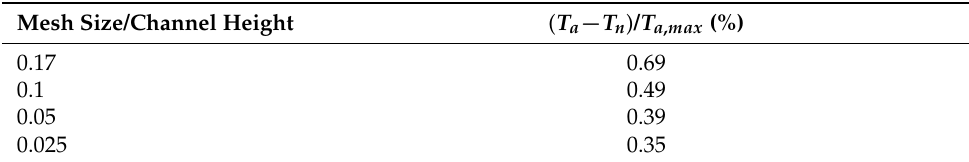
Figure 3. Comparison of temperature rise predictions at the outlet plane, x = L , using chtMultiRegionFoam and theory for Poiseuille profile. Table 1. Average difference between analytical and numerical results for temperature profile at the outlet, for different mesh sizes.